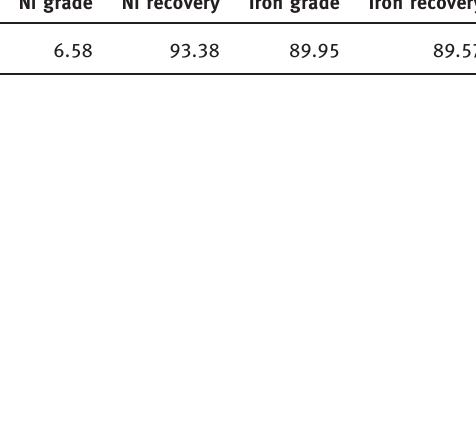
Figure 7: Effects of Al 2 O 3 content on Fe and Ni grade and recovery of ferronickel (Smelting at 1,550°C for 10 min, with coke ratio of 10%, binary basicity of slag as 1.0, 18% of MgO in slag).